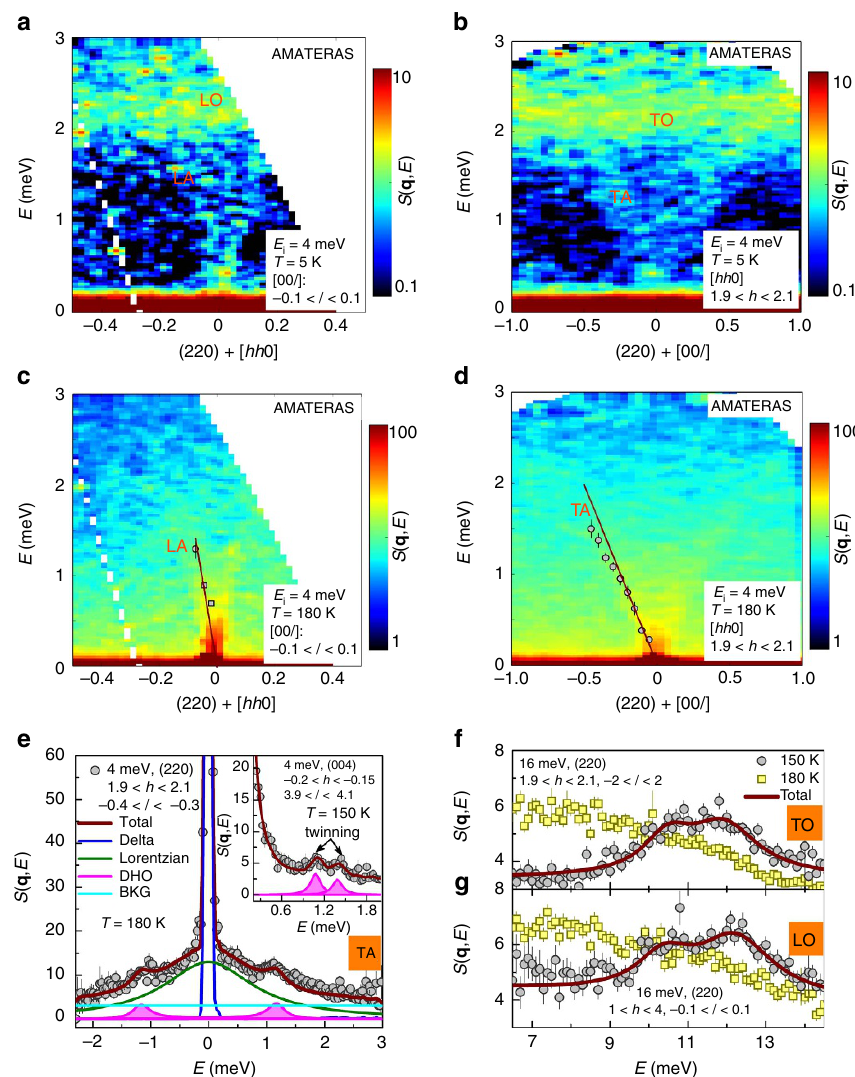
Figure 4 | Phonon broadening at the orthorhombic-to-tetragonal phase transition. ( a , c ) Longitudinal phonons at 5 and 180K of the (220) Brillouin zone; ( b , d ) Transverse phonons at 5 and 180K of the (220) Brillouin zone. TA, TO, LA and LO phonons are labelled. The filled circles and square in c and d are dispersions determined by fitting energy-transfer averaged and momentum-transfer averaged spectra, respectively. The solid lines represent the slopes as approaching the zone centre, which characterize the group velocities. ( e ) Fitting of momentum-transfer averaged TA phonon spectrum of the (220) Brillouin zone at 180K. The Lorentzian and damped harmonic oscillator (DHO) functions describe the quasi-elastic component and the TA phonon, respectively. The inset shows the TA phonon at 150K of the (004) Brillouin zone. The presence of two peaks is because the crystal is twinned in the orthorhombic phase (also see Supplementary Fig. 11). ( f ) Fitting of momentum-transfer averaged TO and ( g ) LO phonons spectra of the (220) Brillouin zone at 150 and 180K with E i of 16meV.